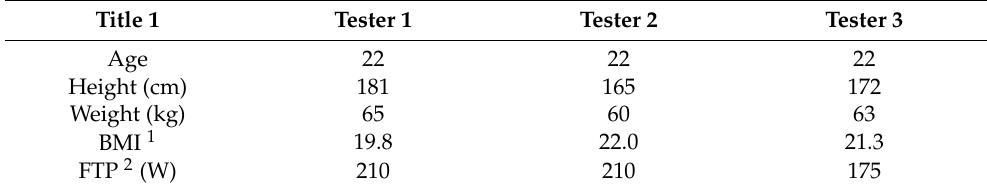
Table 1. Biometric data of the involved testers. BMI is for body mass index; FTP is for functional threshold power.